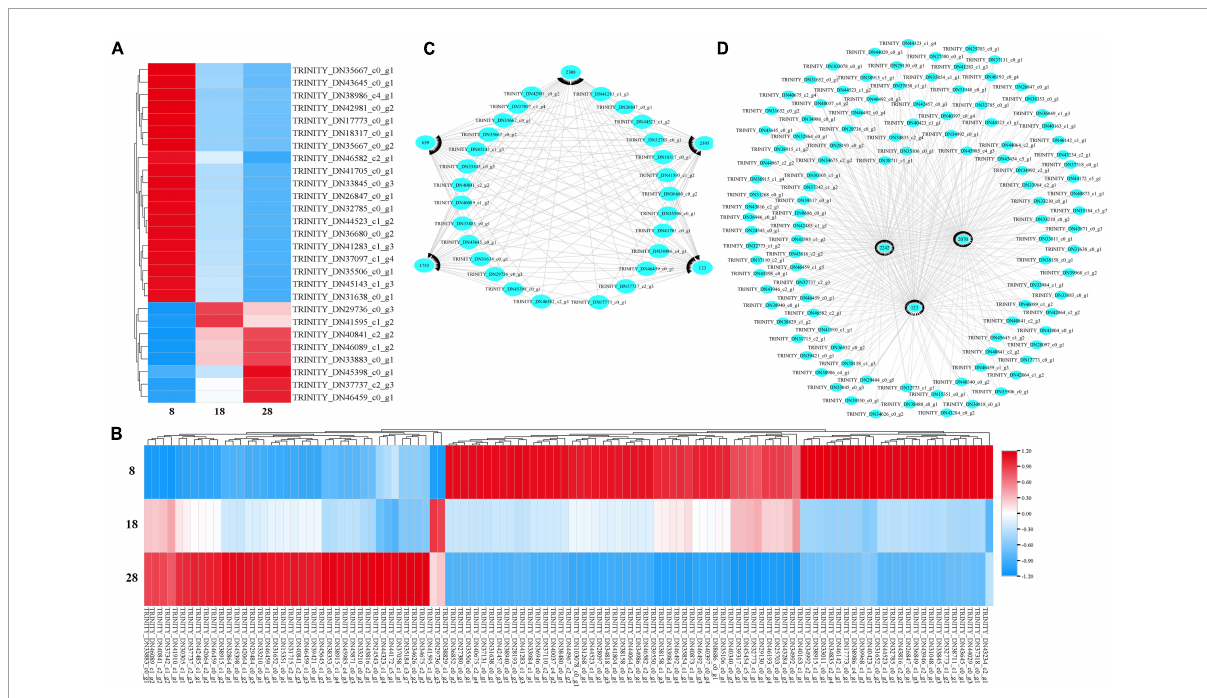
FIGURE9 Heatmap and cytoscape shows the DEGs in KEGG pathways and the interaction between the key metabolites and their associated DEGs that were significantly enriched under metabolic analysis. (A,B) All DEGs identified at 8 vs. 18 dpa and 8 vs. 28 dpa, respectively. (C,D) Key genes between 8 and 18 dpa, respectively. 1,753: thiamine, 2,308: alpha-lactose, 123: salicylic acid (SA), 2,242: docosapentaenoic acid, 2,070: eicosapentaenoic acid, 659: L-glutamic acid, 2,395: DL-alpha-tocopherol.